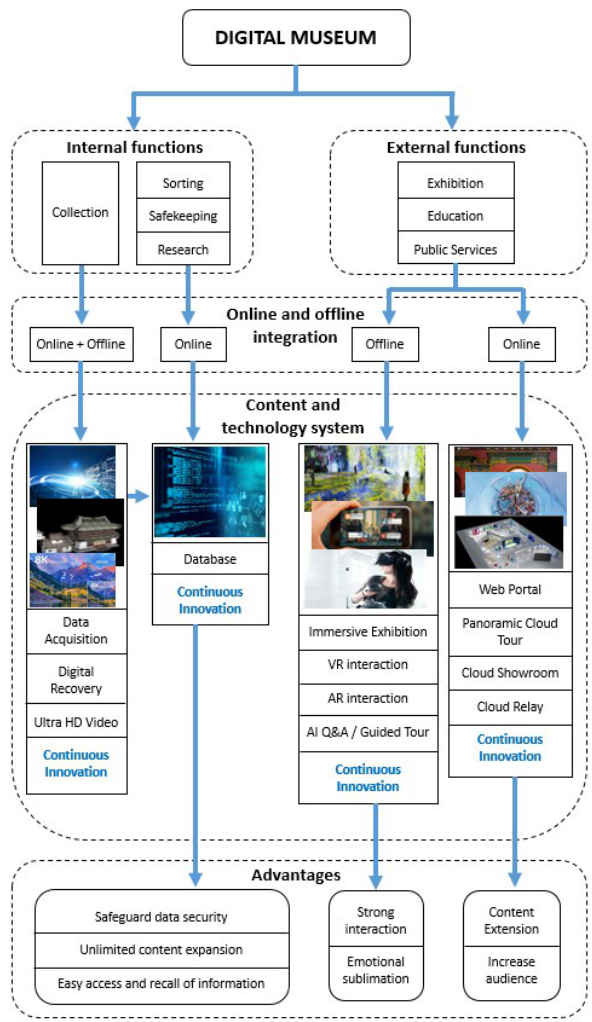
Figure 4. New form of digital museum construction